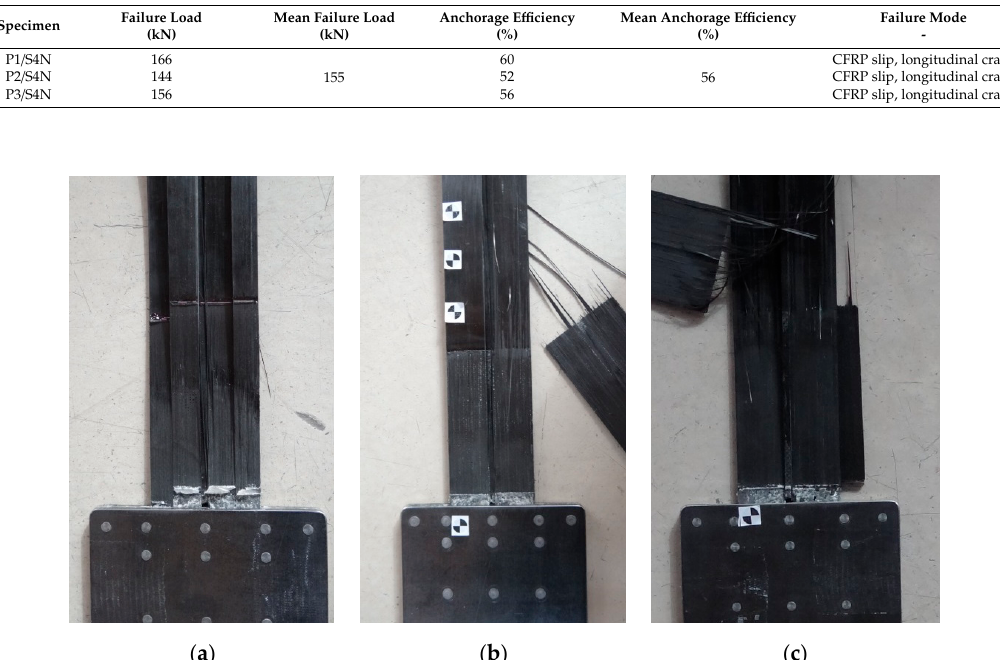
Figure 20. Failure mode of the subsequent specimens in the S4N series: ( a ) P1/S4N, ( b ) P2/S4N, ( c ) P3/S4N.